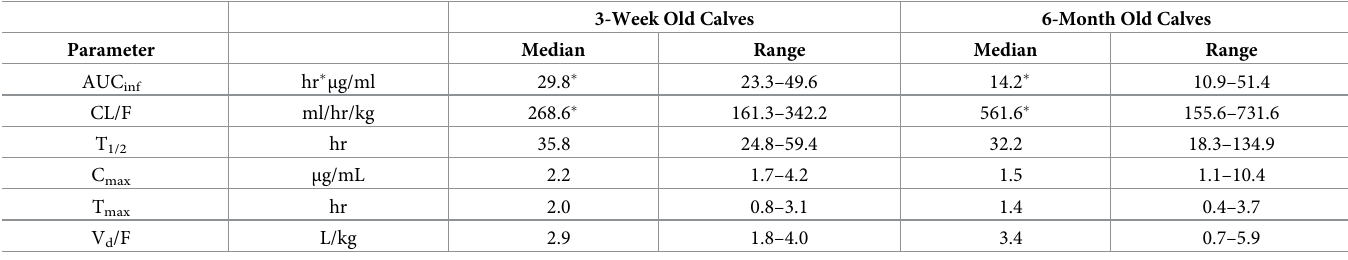
Table 1. Pharmacokinetic parameters for danofloxacin in 3-week old vs. 6-month old calves with respiratory